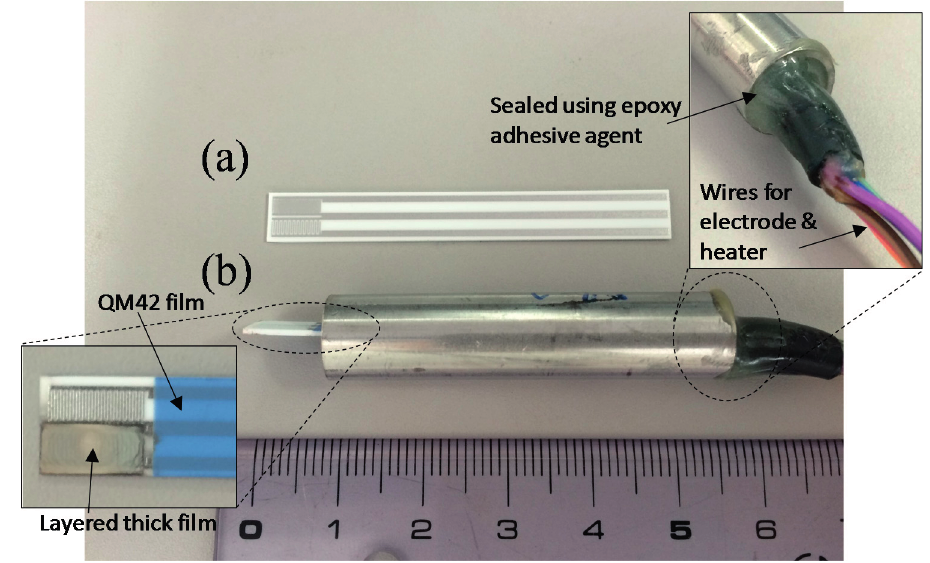
Figure 2. Photograph of ( a ) an alumina substrate with platinum comb-type electrode; and ( b ) a sensor module of a layered thick film sensor using the alumina